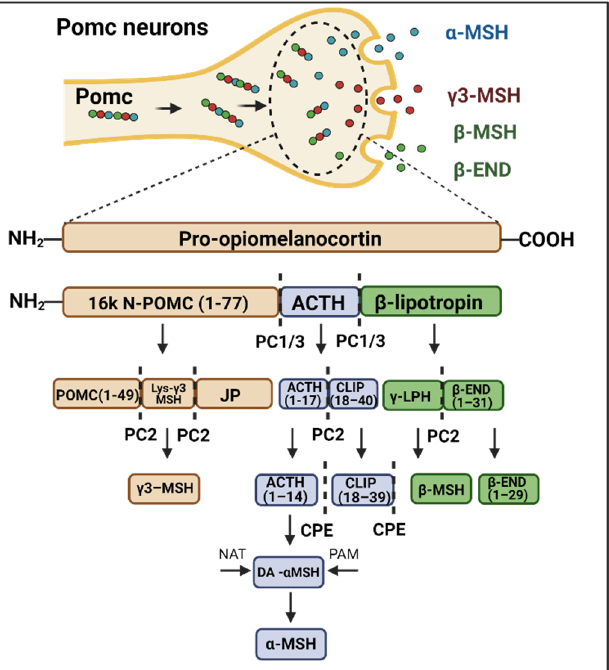
Figure 1. Schematic representation of Pomc processing . The balance between food intake and energy expenditure is mediated in part by α -MSH and β -endorphin ( β -END) production. Pomc cleavage enzymes such as PC1/3 (convertase protein 1), PC2 (convertase protein 2) and CPE (carboxypeptidase E) act in specific portions of Pomc neuropeptide to catalyze its processing. As a result of this process, there is the production of α -MSH, β -endorphin, β -MSH and γ 3-MSH, which are biologically active molecules.